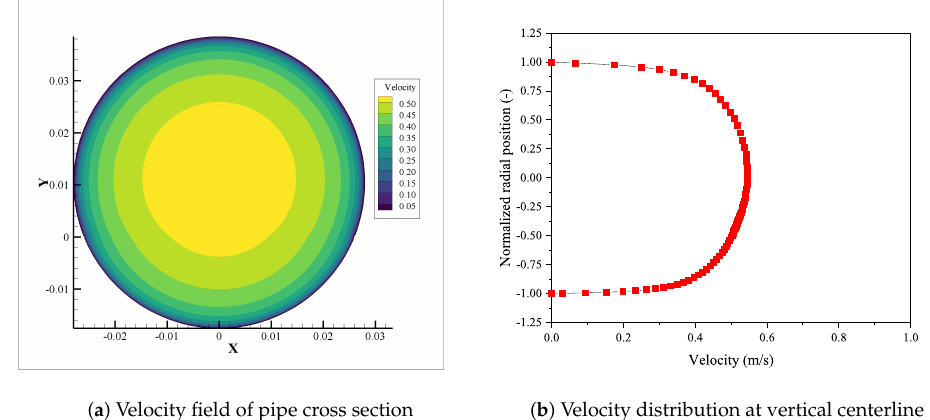
Figure 10. Calculated velocity field of the pipe cross section at mixed velocity 0.43 m/s and water cut 0.25 of SST k − ω turbulence